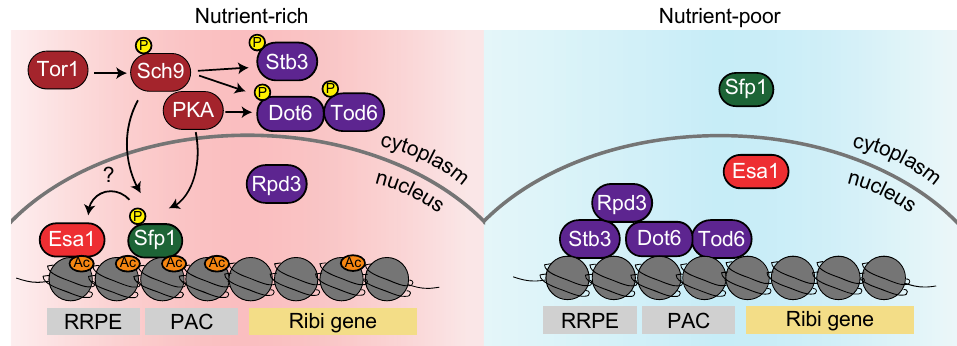
Figure 5. Regulatory mechanisms of Ribi gene expression in S. cerevisiae . In nutrient-rich conditions (the pink area on the left), Sfp1 resides at Ribi gene promoters without Ifh1. Sfp1 might recruit Esa1 and upregulate the transcription of Ribi genes. Stb3, Dot6, and Tod6 phosphorylated by Sch9 and PKA are in the cytoplasm. During nutrient starvation (the blue area on the right), Stb3 binds to the RRPE motif (AAAAATTT) of Ribi genes, and Dot6/Tod6 accumulates at the PAC motif (CTCATCG). As a result of the recruitment of Rpd3 by these factors, Ribi gene expression is repressed.